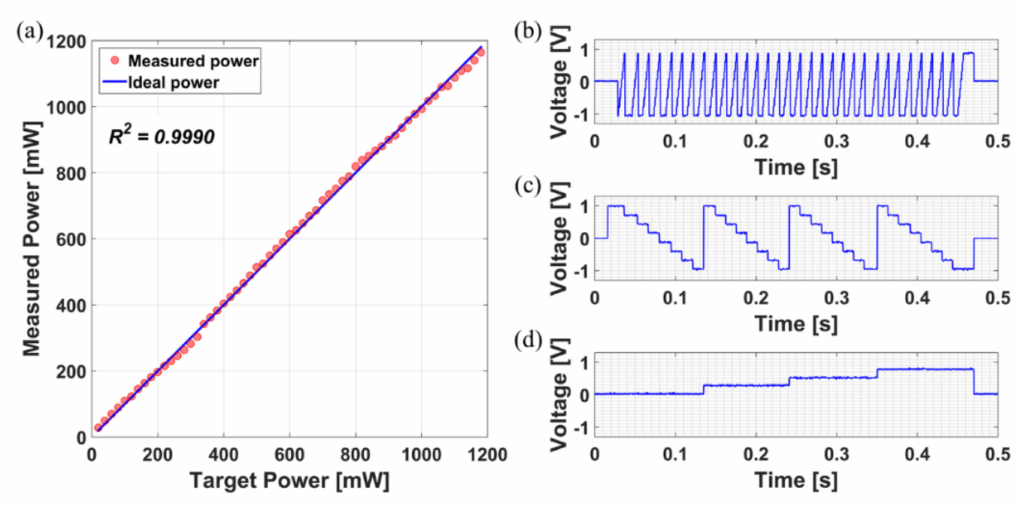
Figure 5. Verification graphs of ( a ) the laser power controller and the 3D scanner for the ( b ) X − axis, ( c ) Y − axis, and ( d ) Z −